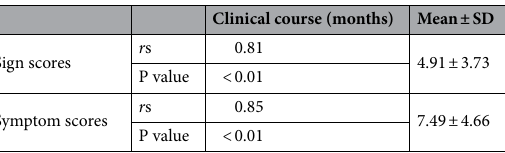
Table 4. Relationship between ocular symptoms/sign scores and the duration of